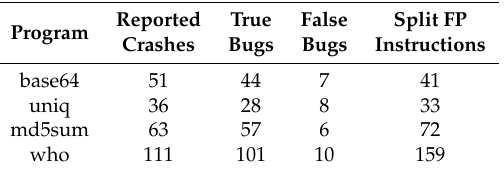
Table 3. Filtering out detected crashes by Bug Validation and the number of split floating-point instructions in LAVA-M dataset.